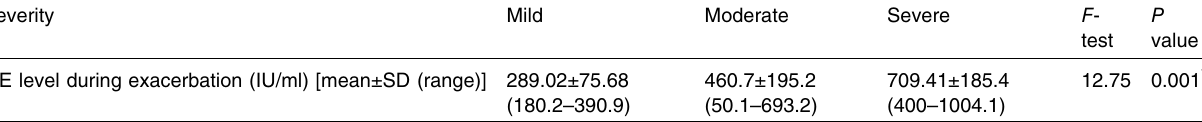
Table 5 Comparison of serum IgE levels among mild, moderate, and severe exacerbated asthma